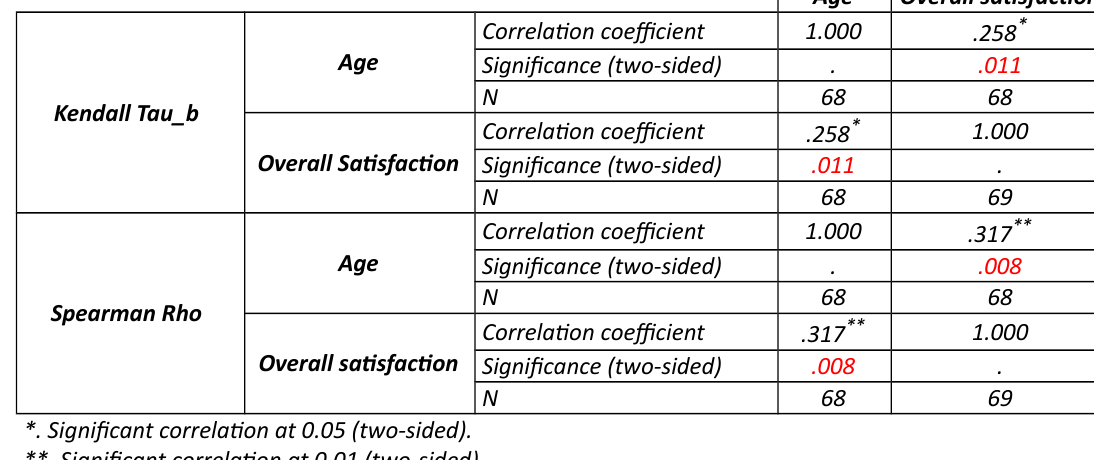
Table 1. Correlatons between students’ age and their